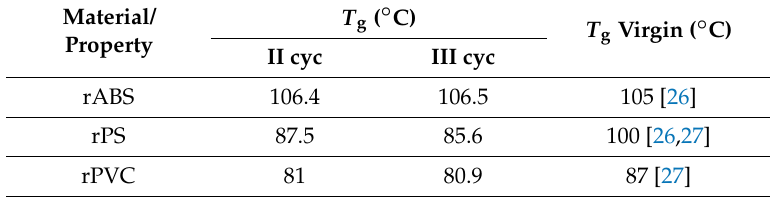
Table 3. Thermal parameters of rABS, rPS and rPVC.